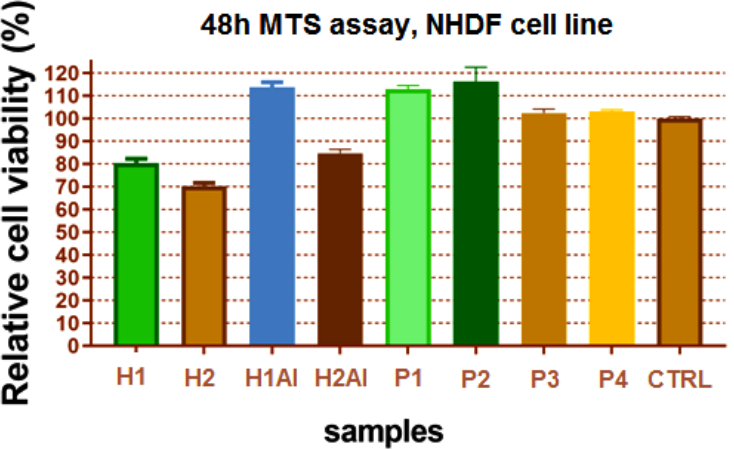
Figure 11. The cell viability on the NHDF cell line of the studied gels.